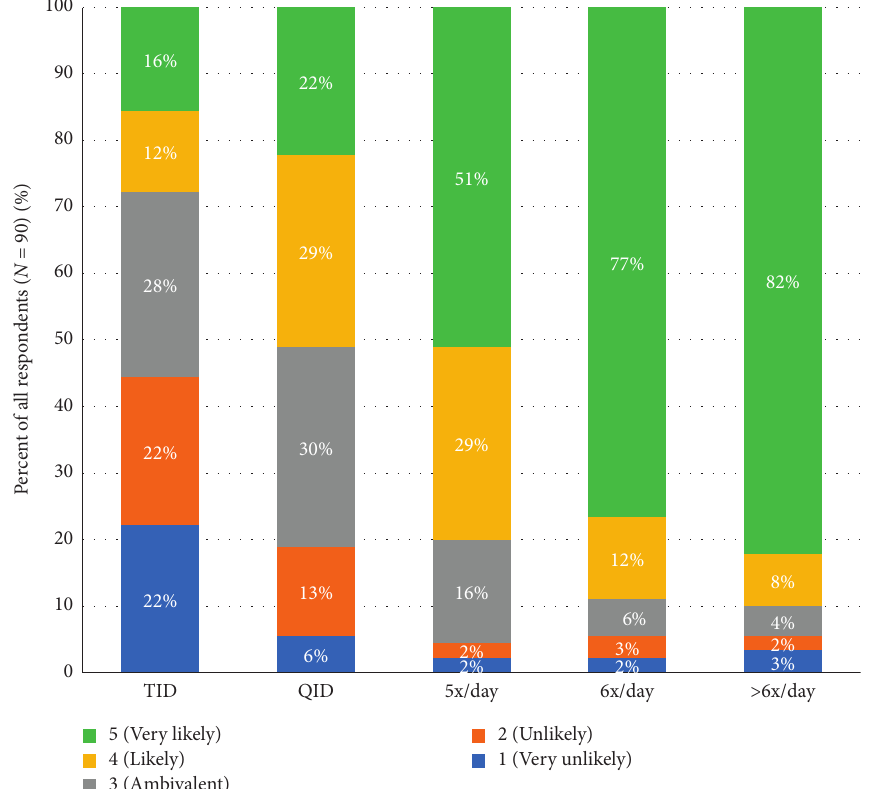
Figure 3: Likelihood of switching to CD-LD ER: multiple OFFs and no dyskinesia per CD-LD IR dosing